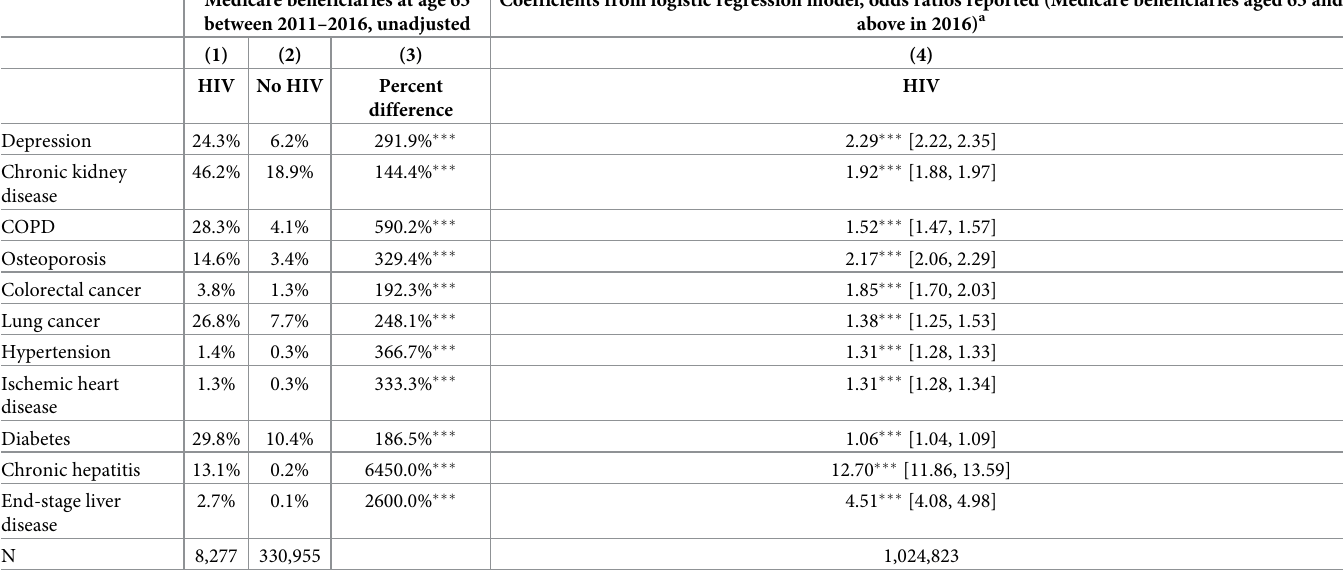
Table 3. Prevalence of health outcomes, unadjusted means and odds ratios reported. Medicare beneficiaries at age 65 between 2011–2016,